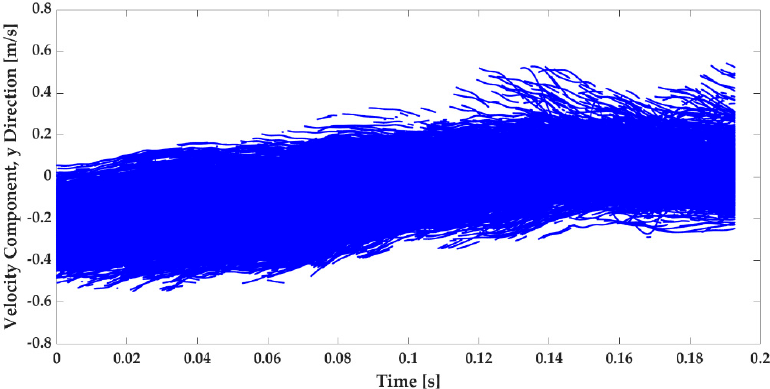
Figure 5. Velocity component in y direction from twenty videos, which involves 40,000 frames extracted via Lagrangian-particle tracking technique.